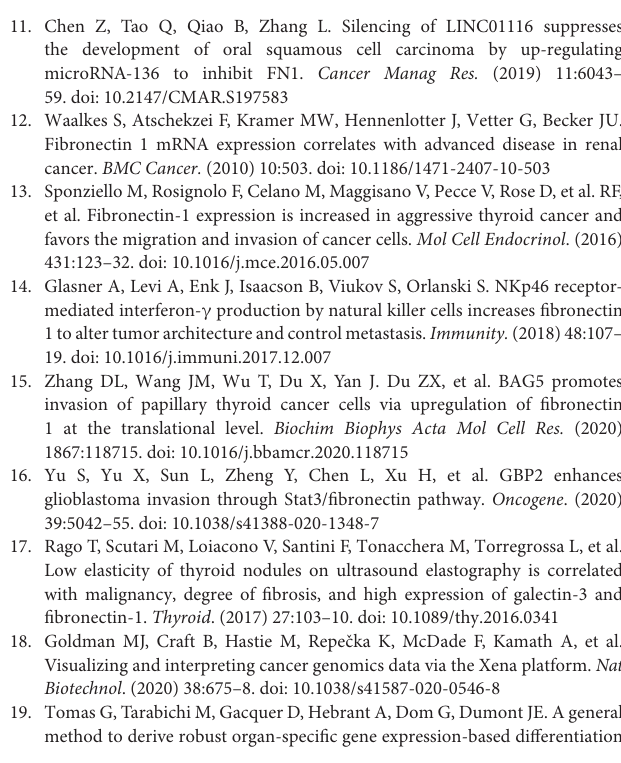
Supplementary Figure 1 | Flow diagram of the study. Supplementary Table 1 | The significantly enriched GO terms of the common DEGs (BP, biological process; CC, cellular component; DEG, differentially expressed gene; GO, Gene Ontology; MF, molecular